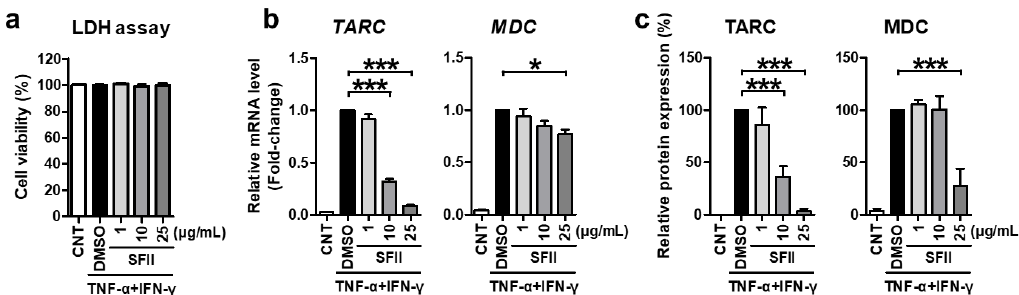
Figure 1. Skullcapflavone II (SFII) significantly suppressed TNF-α/IFN-γ-induced thymus- and activation-regulated chemokine (TARC) and macrophage-derived chemokine (MDC) expression. ( a ) HaCaT cells were treated with 1, 10, and 25 μg/mL of SFII or 0.1% DMSO control (CNT or DMSO labeled) for 24 h, and the LDH assay was performed. For other experiments, cells were stimulated with TNF-α/IFN-γ after SFII pretreatment. ( b ) Then, total RNA was extracted at 18 h, and the mRNA expression of TARC and MDC was measured by quantitative real-time PCR. ( c ) Conditioned media were harvested 24 h after stimulation, and TARC and MDC protein expression was measured using ELISA. The mRNA and protein levels, relative to those in the TNF-α/IFN-γ-stimulated DMSO control samples, are presented as mean fold- changes ± SEM of independent experiments (N = 4 or 5). Statistical comparisons were performed using a one-way ANOVA followed by Bonferroni’s post-hoc test (* p < 0.05, *** p < 0.001).